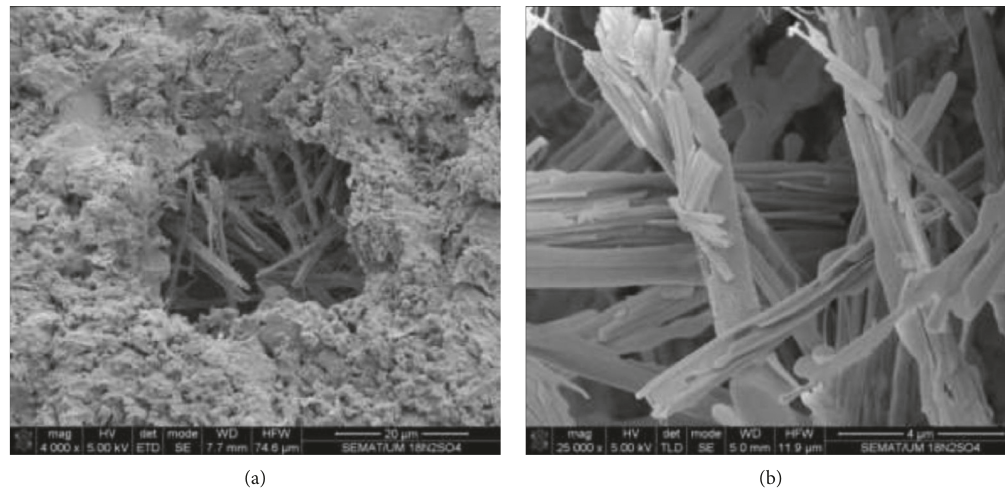
Figure 11: (a) The SEM shot of the concrete treated with coat after 18 months in liquid Na